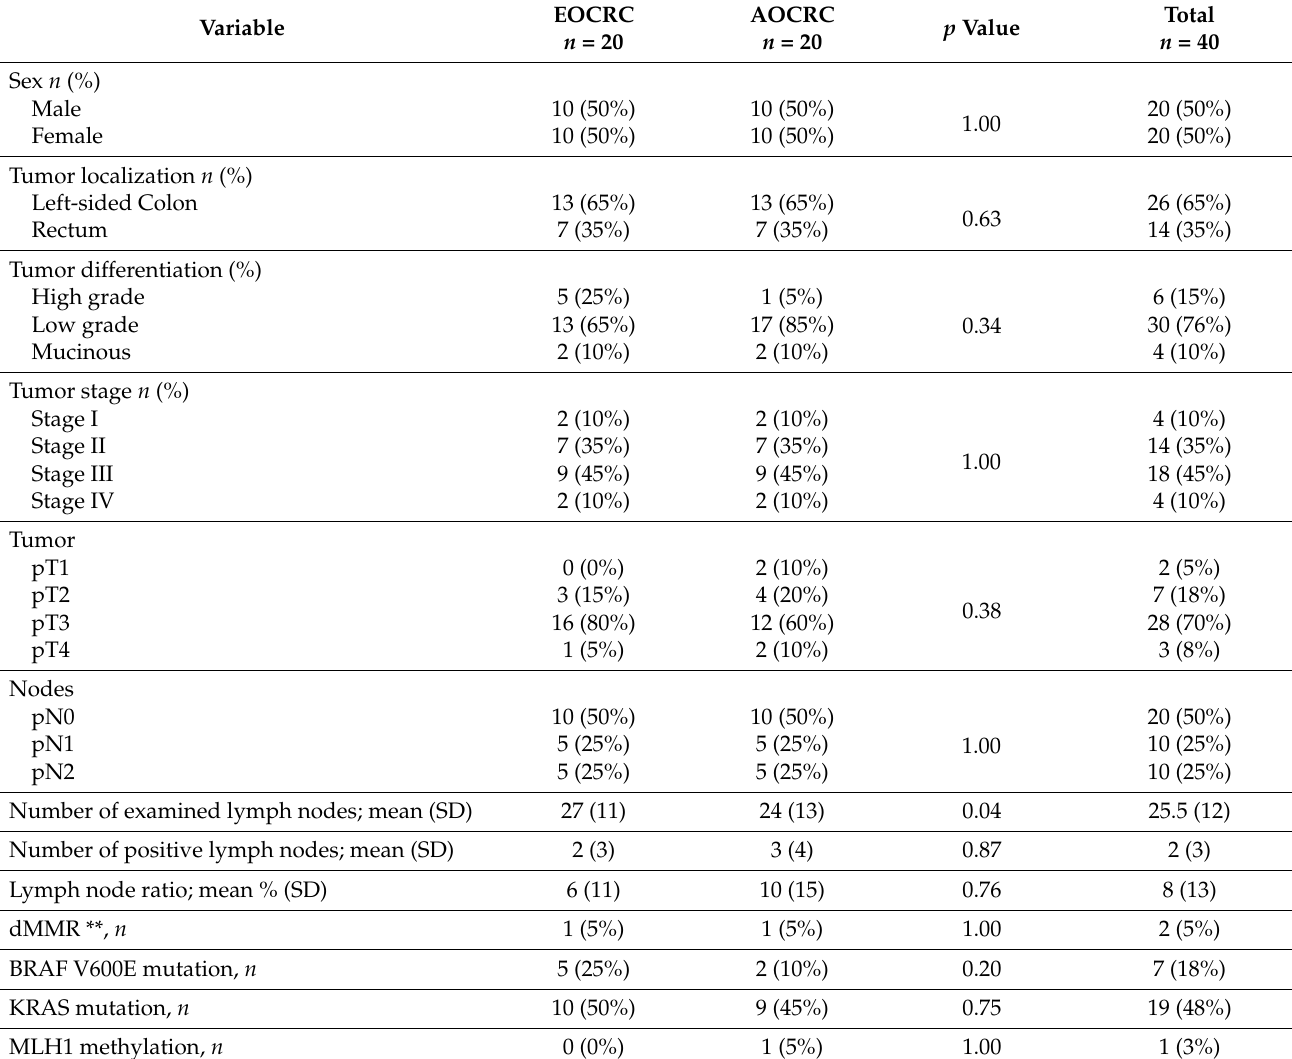
Table 1. Clinical, pathological, and molecular characteristics of the groups according to age